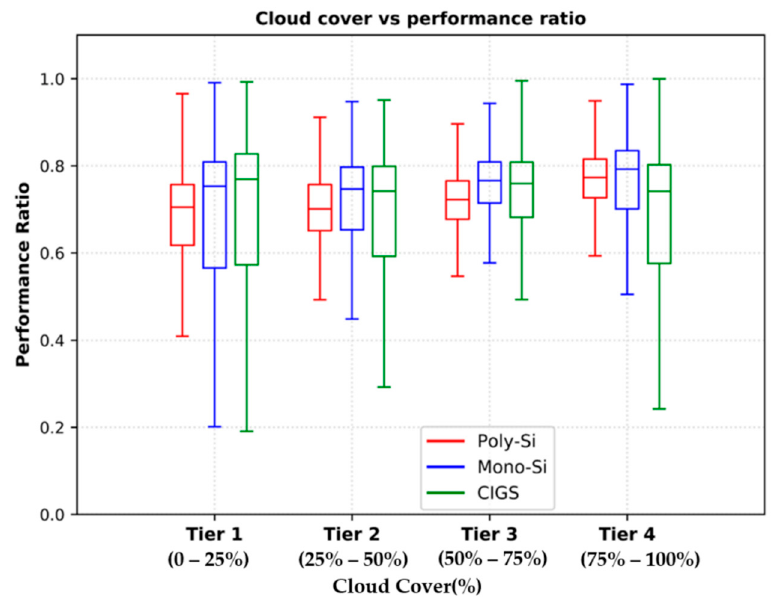
Figure 6. Cloud cover vs. performance ratio.